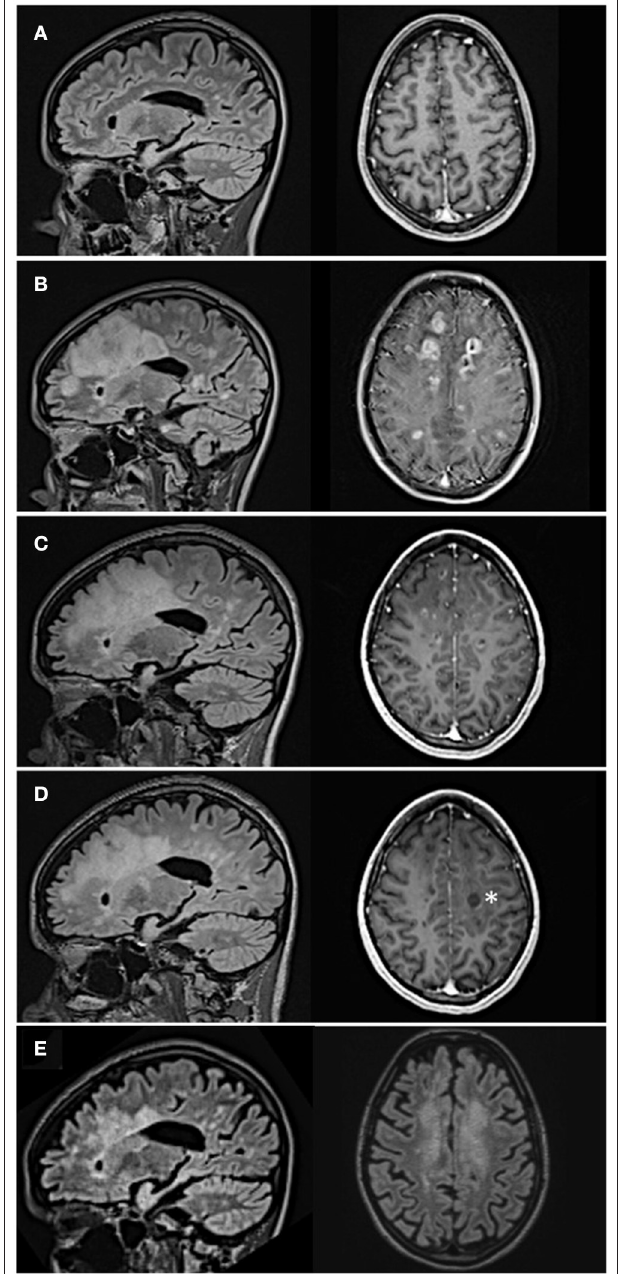
FIGURE 1 | MR-imaging during disease course. Sagittal FLAIR- and axial T1 gadolinium sequences. (A) Moderate lesion load under fingolimod treatment. (B) Frontoparietal tumefactive lesions with disseminated Gadolinium-enhancement 6 weeks after discontinuation of fingolimod. (C) Remittent Gadolinium-enhancement after four cycles of plasmapheresis. (D) Further remission at re-admission 2 weeks after the last cycle of plasmapheresis; asterisk indicates active lesion. (E) Lesions decreasing in size 6 months after ocrelizumab initiation (only axial FLAIR available). symptoms were primarily neuropsychiatric including affective incontinence and motoric aphasia. To our knowledge, only one similar case was reported in the literature by Ashtari et al.